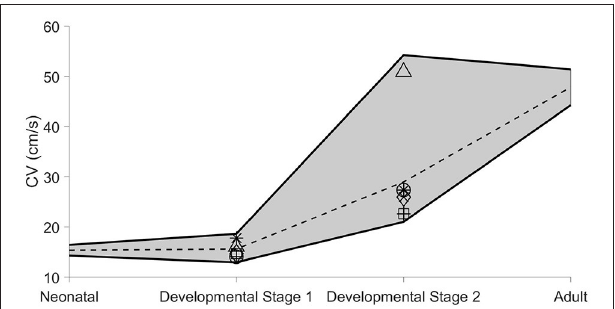
FIGURE 6 | Age-associated ranges of conduction velocity (CV). The range of CV values (see text for details) are shown as functions of age-dependent progression. Parameter ranges and markers for each stage are shown in Supplementary Table 2 . The dashed line shown for each stage represents the average CV value over all conditions within the specified parameter ranges. Cleft width w = 20 nm